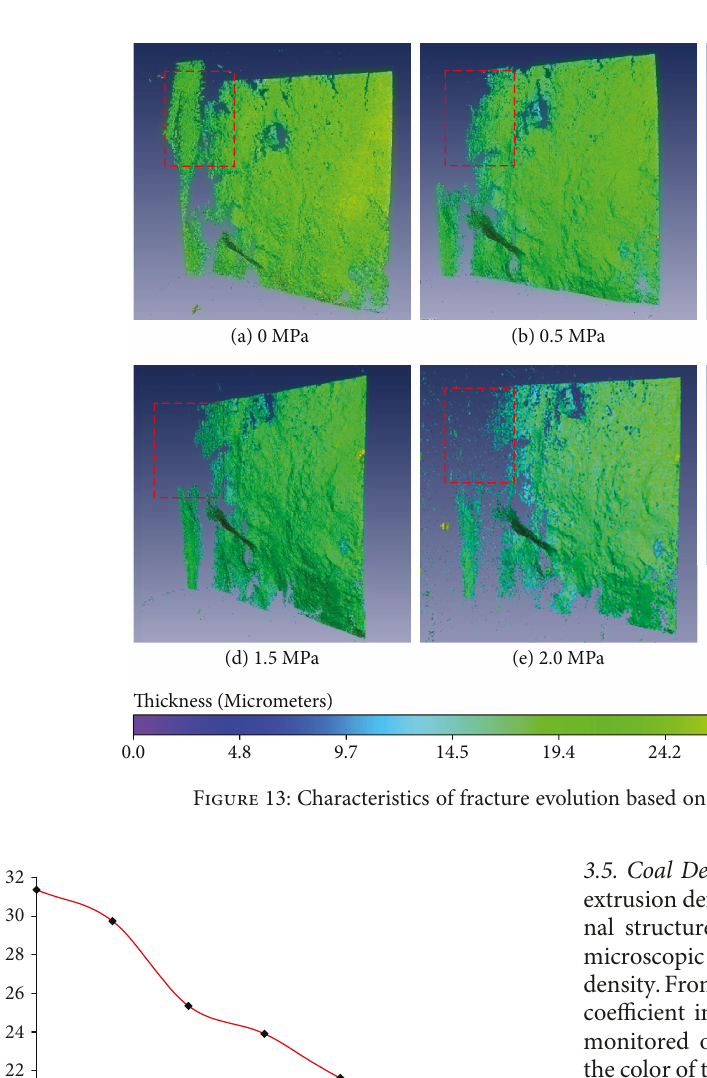
Figure 12: Fracture extraction in CT image.